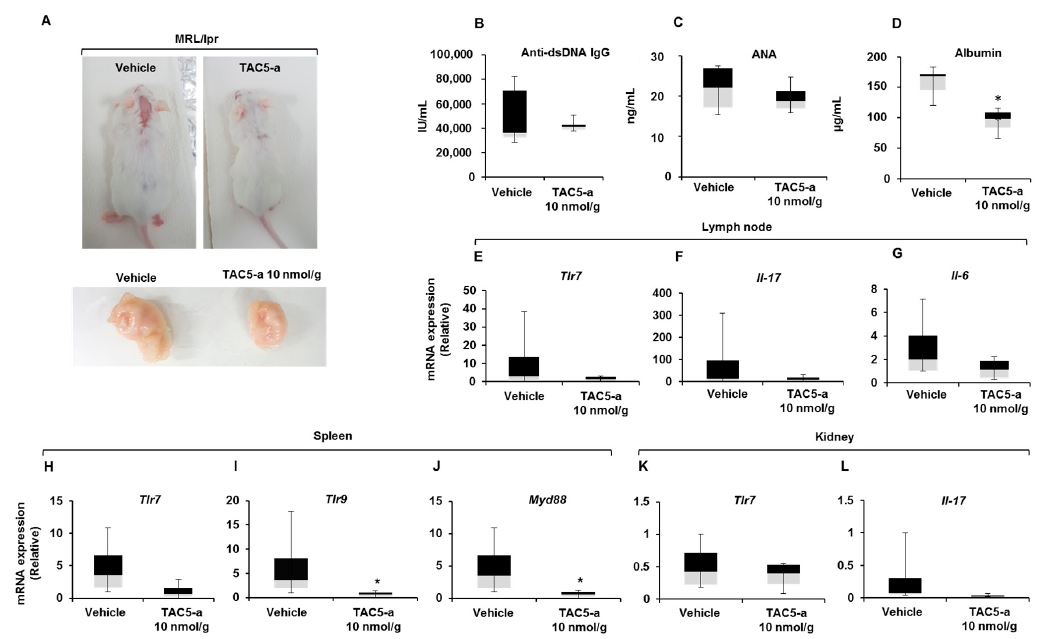
Figure 6. Effect of TAC5-a in a mouse model of systemic lupus erythematosus (SLE). ( A ) Effect of TAC5-a treatment in lupus-prone mice (MRL/lpr) having the SLE phenotype ( n = 5). The enlargement of the lymph node was markedly reduced in TAC5-a-treated mice. ( B ) Amount of anti-dsDNA antibodies and ( C ) antinuclear antibody in serum, as determined by an ELISA. ( D ) The albumin content in urine, as determined by the ELISA. ( E – L ) The relative expression levels of specific genes in the lymph node, kidney, and spleen from MRL/lpr mice, determined by quantitative real-time PCR. The name of the analyzed gene is indicated in each panel. Data were normalized to Gapdh . The exact Wilcoxon Rank Sum test (which is numerically equivalent to the Mann–Whitney U test) was performed to compare the mean values in the two groups. * p < 0.05 and ** p < 0.01.